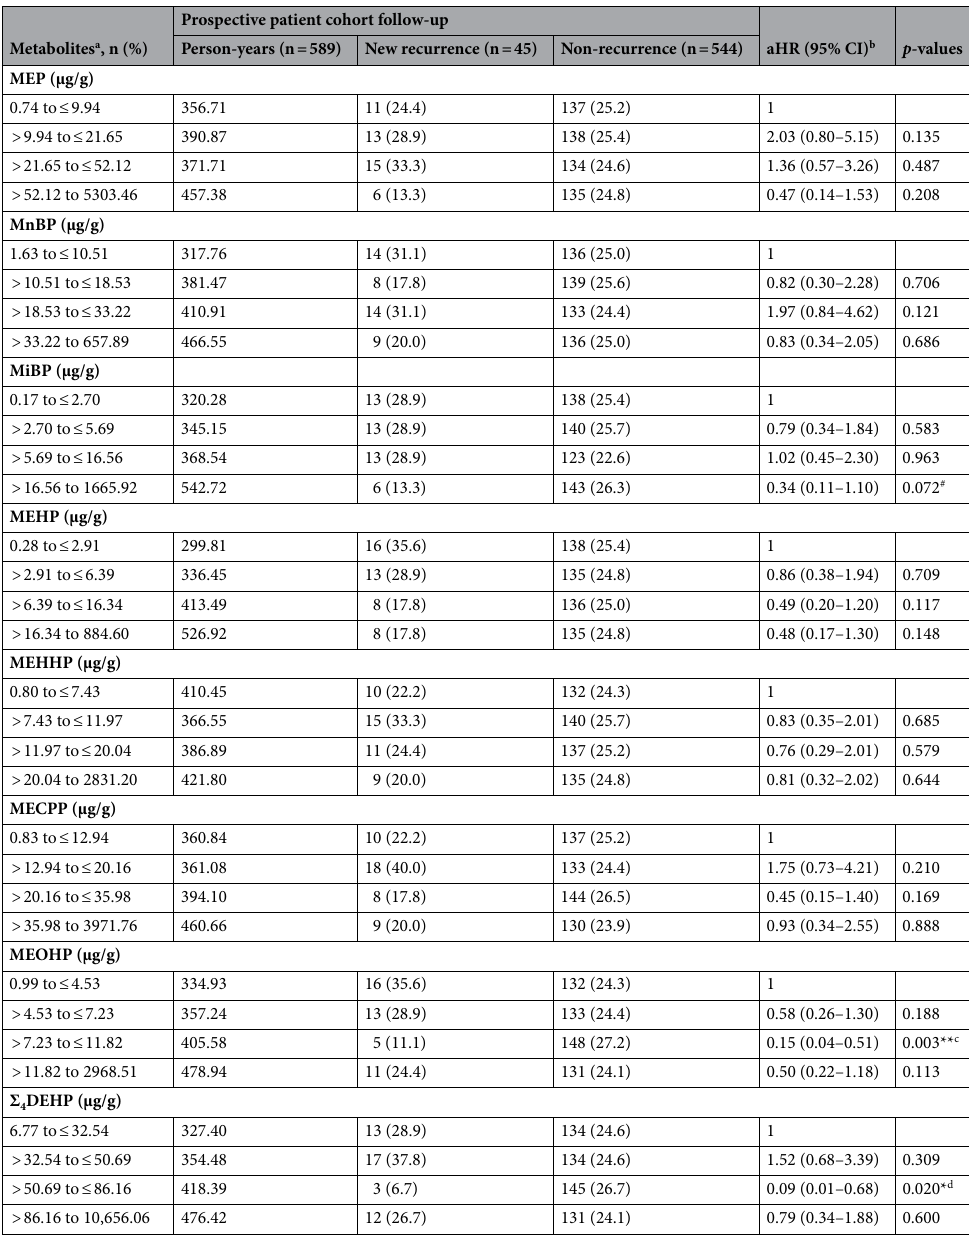
Table 2. Association between recurrent breast cancer and urinary phthalate metabolite concentrations. HR hazard ratio, CI confidence interval. a The urinary concentration unit of phthalate metabolites were μg/g creatinine and were categorized into quartiles with the first quartile being defined as the reference group. b HR was calculated by multivariable Cox proportional hazards model and adjusted for marriage, smoking state, TNM stage, grade, tumor size, invasive, PR status, chemotherapy, and radiotherapy, shown as aHR (95% CI). c The p -value was still significant after Bonferroni correction ( p -value = 0.024; 0.003 multiplied by eight phthalate comparisons). d The p -value was not significant after Bonferroni correction ( p -value = 0.16; 0.02 multiplied by eight phthalate comparisons). # p- values < 0.1, * p- values < 0.05, ** p- values <